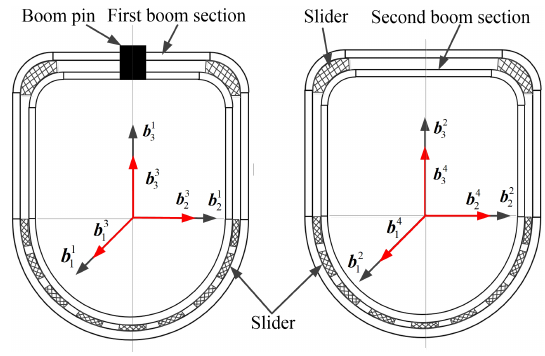
Figure 6. Constraint relationships of the boom sections.